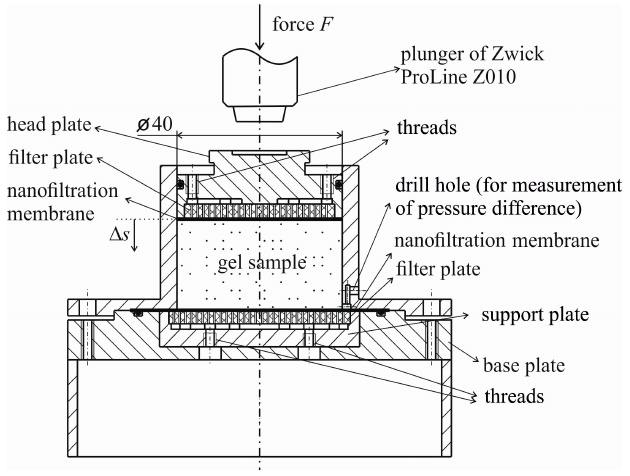
Figure 7. Measurement equipment for enforced syneresis, with small modifications compared to [5].